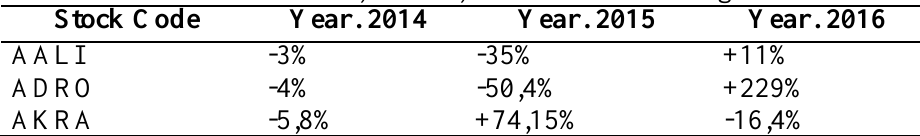
Table 1 Return Stock of AALI, ADRO, AKRA in the Closing of